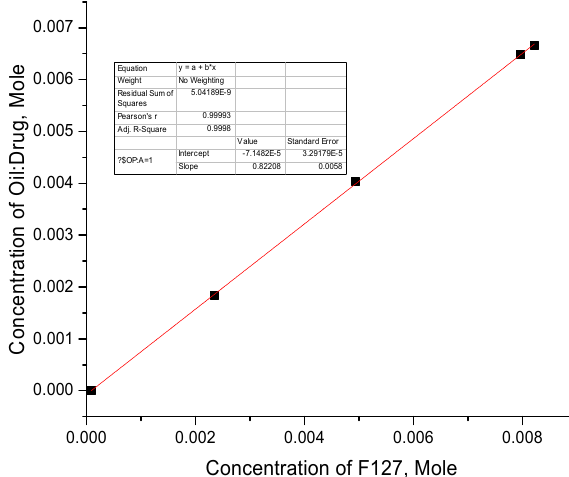
Fig. 8. Optimal binding ratio of Oil+Drug to F127 in microemulsions